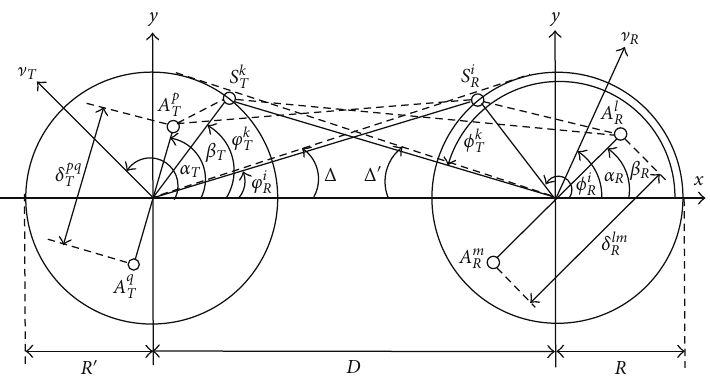
Figure 1: The modified geometrical two-ring model for a 2 × 2 MIMO channel with scatterers around mobile transmitter MS T (left) and mobile receiver MS R